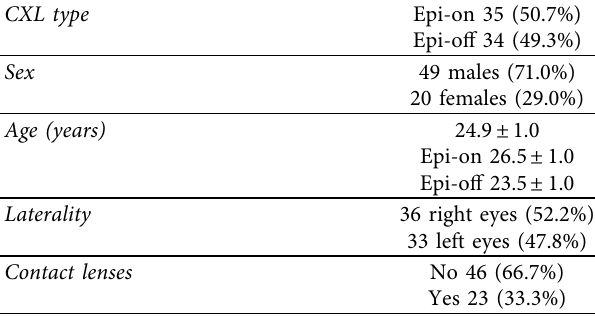
Table 1: Demographic data of the patients enrolled in study.